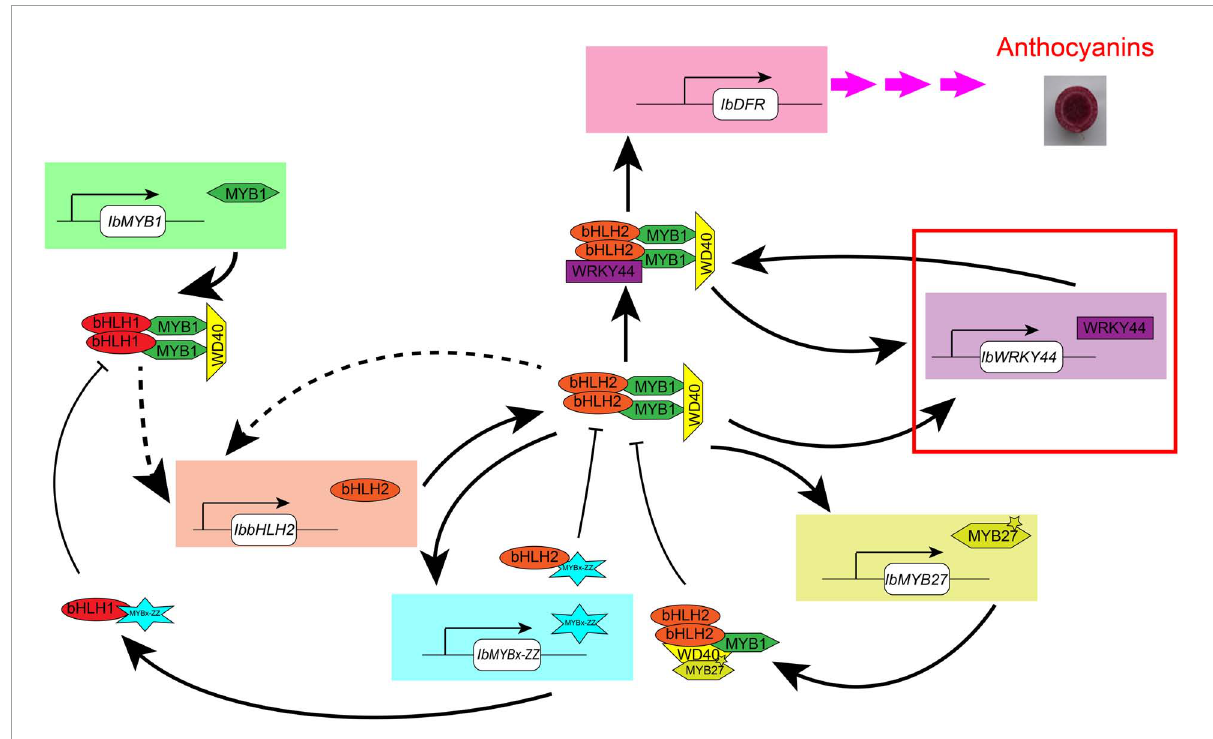
FIGURE9 Model of the anthocyanin regulation network in tuberous roots of sweet potato. This model is modified in accordance with the method of Albert et al. (2014). IbMYB1 is expressed and then forms a MBW activation complex with bHLH1 and WD40, which activate the expression of IbbHLH2 . Then, a core MBW activation complex containing bHLH2 forms combines with WRKY44 protein, forming a MBWW complex, and activates the expression of the anthocyanin biosynthesis genes, ultimately resulting in anthocyanin accumulation. The MBWW complex can reinforce the expression of IbWRKY44 . The core MBW activation complex can also reinforce the expression of IbbHLH2 and activate the expression of IbWRKY44 and MYB repressors, like IbMYBx-ZZ and IbMYB27 . Then, MYB repressors collaborate with bHLH and WD40 protein and inhibit the expression of anthocyanin biosynthesis genes. Arrow with solid line represents regulation proven in sweet potato leaves, and dotted arrow represents the regulation that has not been proven yet. The red rectangle represents novel TF that we found to be involved in anthocyanin biosynthesis in sweet